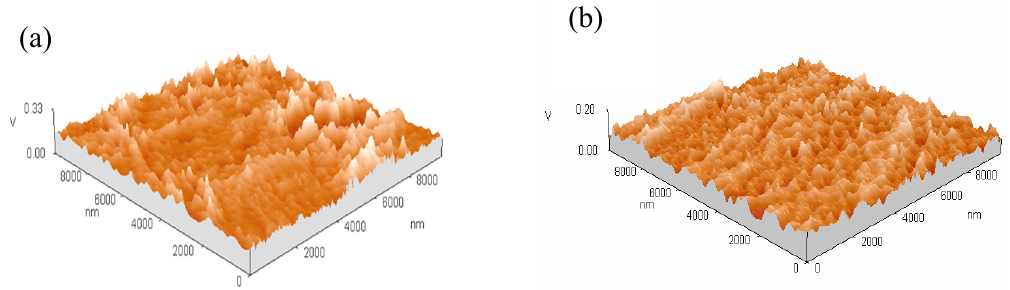
Figure 7. AFM images and mean grain sizes of both deposits obtained at − 1.15 V for 60 s: ( a ) Ni; and ( b ) Ni-Y 2 O 3 .